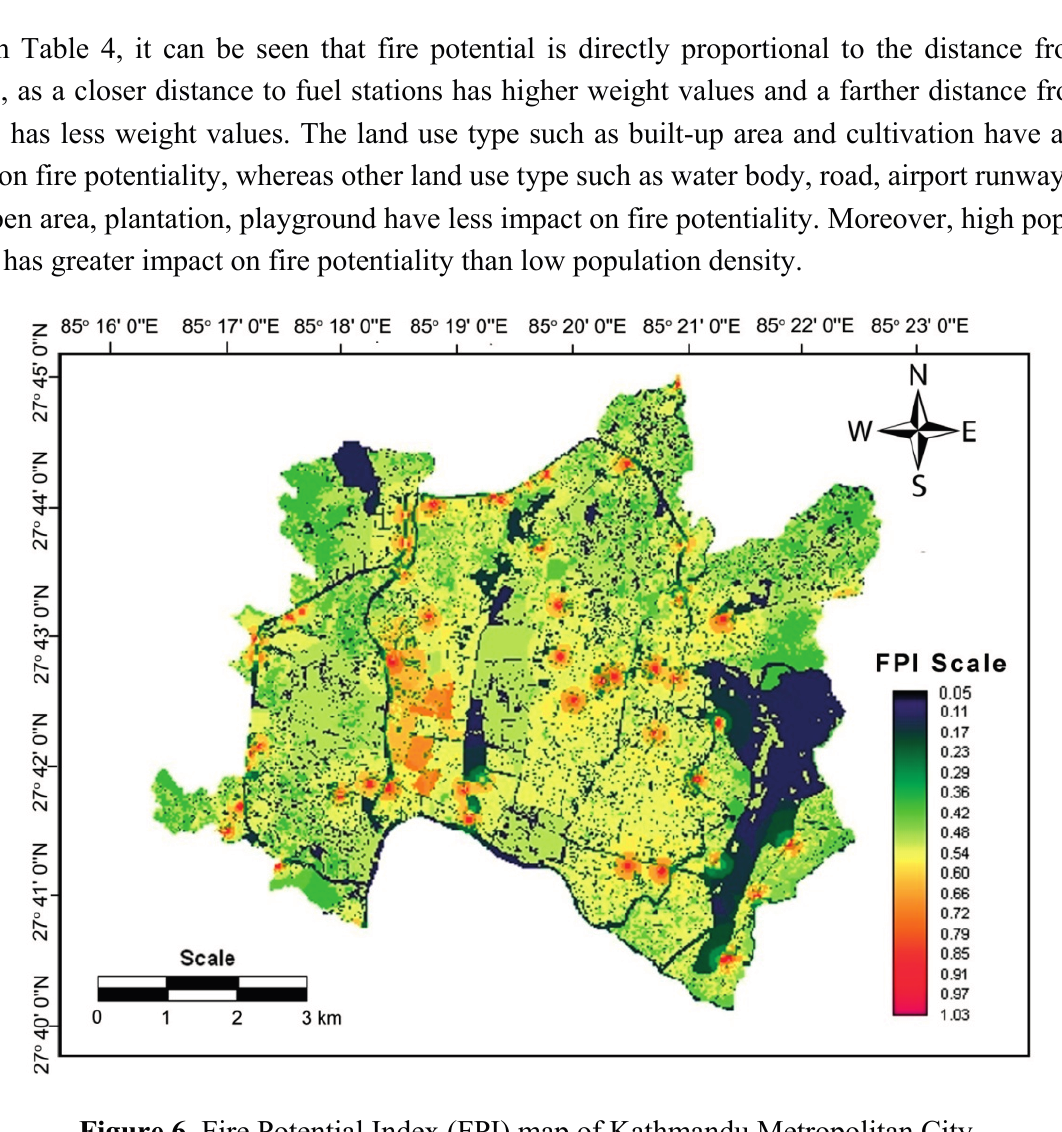
Figure 6. Fire Potential Index (FPI) map of Kathmandu Metropolitan